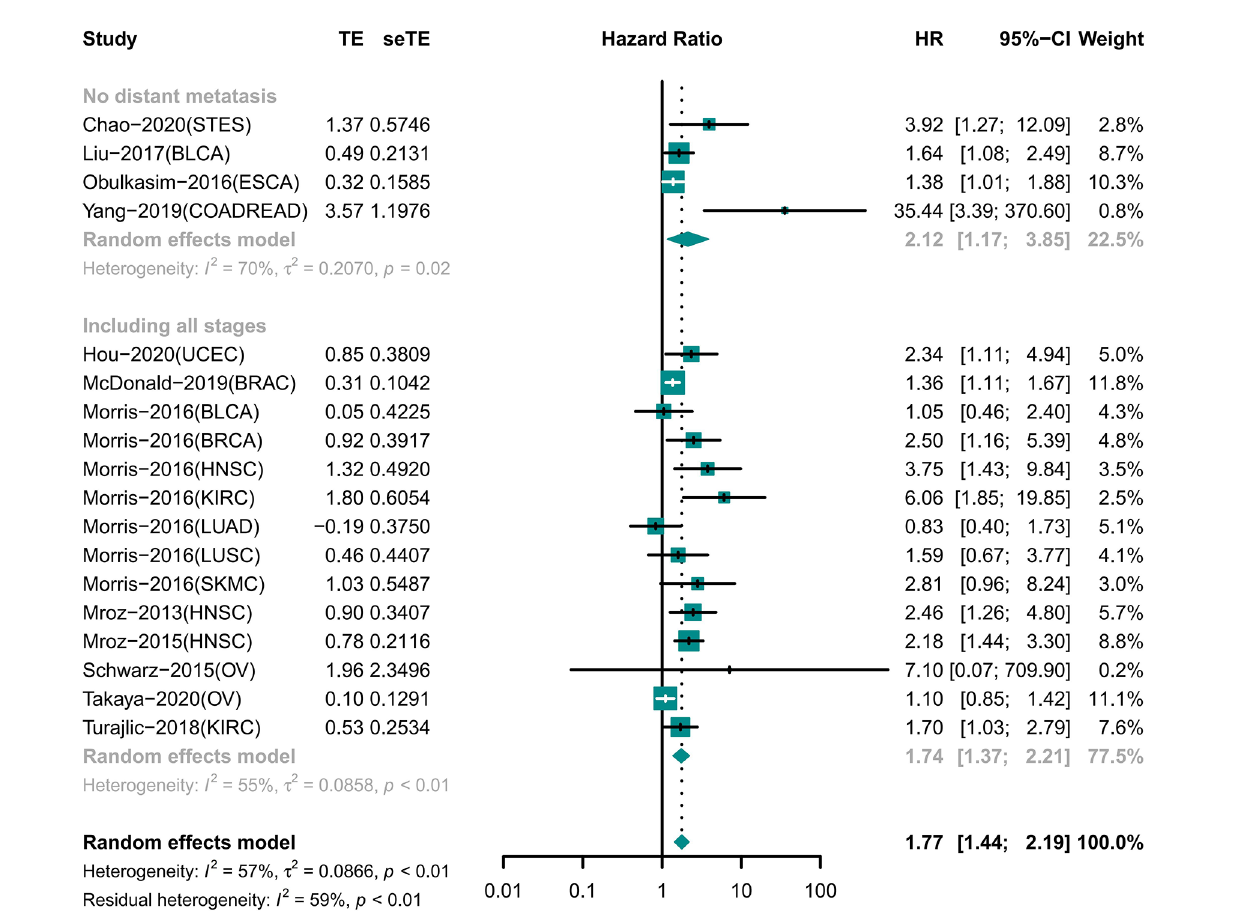
FIGURE 3 | Forest plot of intratumor heterogeneity (ITH) with prognosis in different tumor